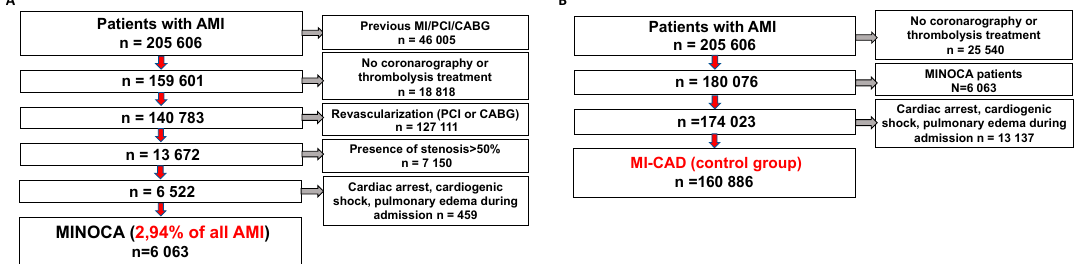
Figure 1. Study flowchart. ( A ) Minoca group flowchart ( B ) MI ‐ CAD flowchart. AMI = acute myocardial infarction, MI = myocardial infarction, PCI = percutaneous coronary intervention, CABG = coronary artery bypass grafting, MINOCA = myocardial infarction with non ‐ obstructive coronary arteries, MI ‐ CAD = myocardial infarction with obstructive coronary artery disease.